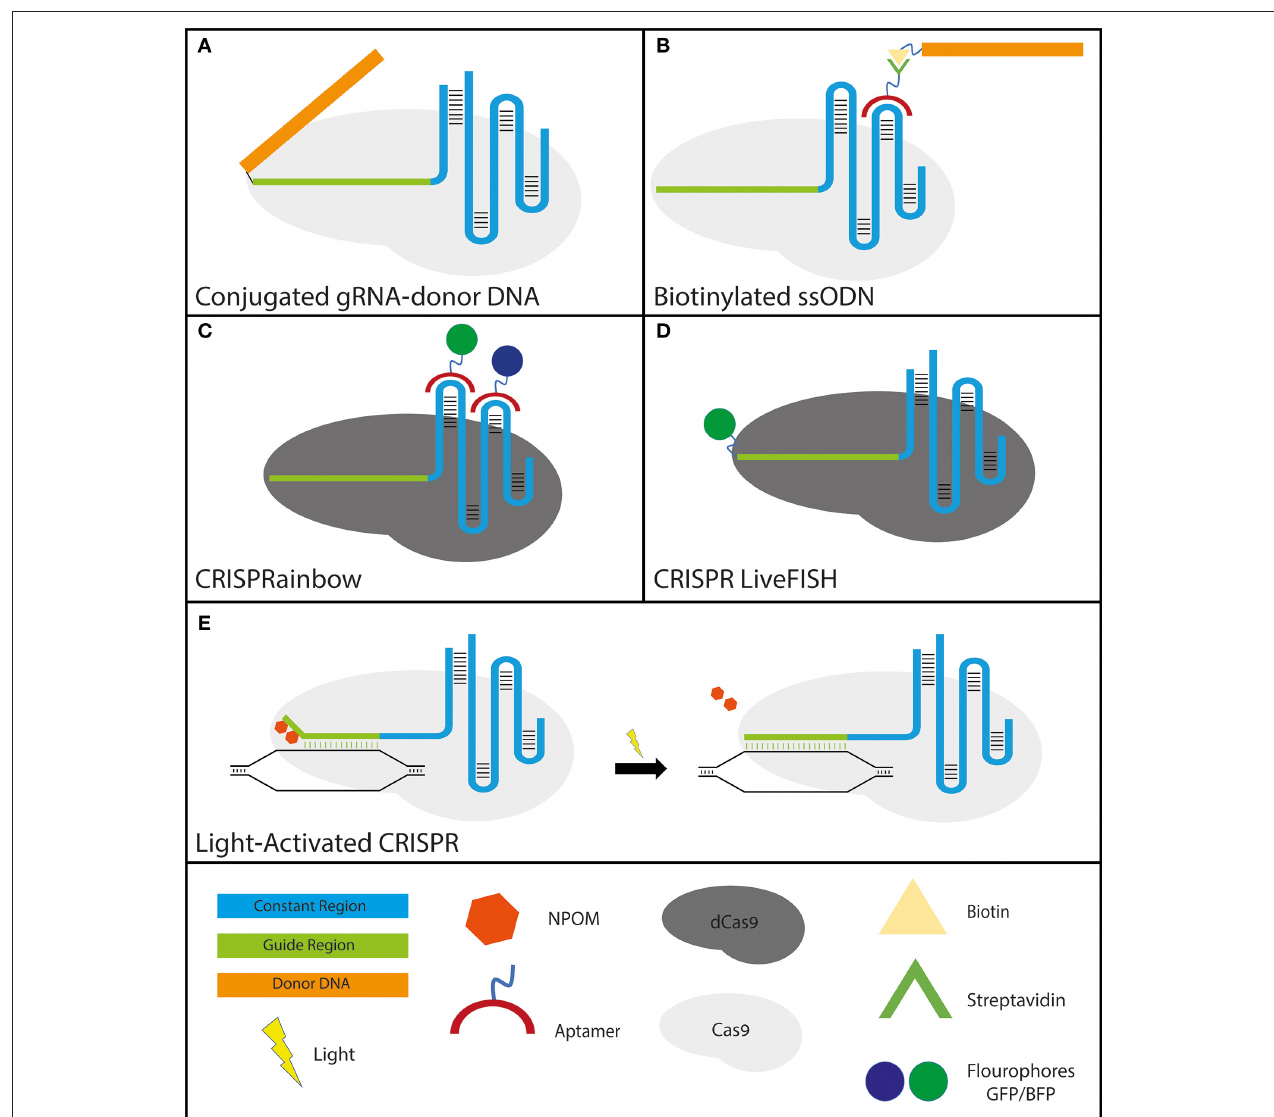
FIGURE 3 | Various applications of engineered gRNAs. (A,B) –gRNA modifications to improve HDR: (A) crRNA-donor DNA conjugate. The donor DNA is fused to the 5 ′ end of the guide region. (B) sgRNA molecule with streptavidin-binding aptamers that attach to either the tetraloop or stem-loop 2 (the two loops protruding